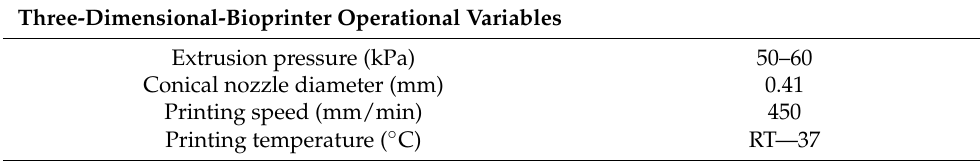
Table 2. Summary of printing parameters used for the